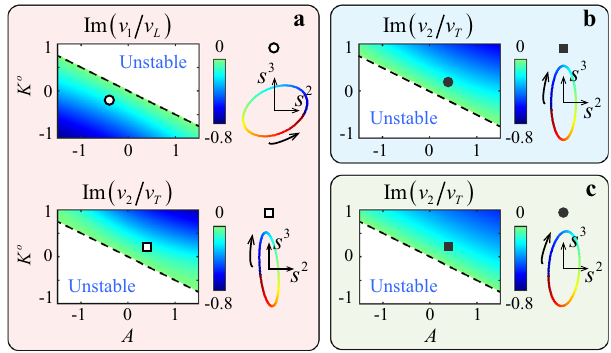
Fig. 2 Gyro-odd elastodynamics in unbound media. a Phase diagrams showing the stability transition in the odd-elastic parameters space. The other material properties are chosen as μ = 0.5 and α = 0.5. The dashed lines mark the transition boundary, that is A + 2 K o = 0. The colored (stable) regions depict the imaginary parts of v 1,2 . As indicated by the symbols, some odd-elastic engine cycles are provided in the strain subspace ( s 2 , s 3 ) to analyze the mechanical work done on the solid. Likewise, ( b , c ) present the results for the cases α = 1 and α = 2, respectively, but now only the v 2 branch